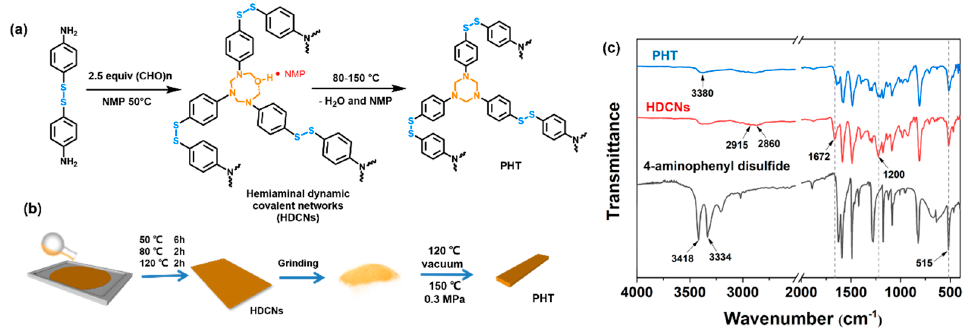
Figure 1. ( a ) The synthetic route of the polyhexahydrotriazine thermosets (PHT). ( b ) Preparation process of PHT bars. ( c ) FTIR spectra of hemiaminal dynamic covalent networks (HDCNs) and PHT.